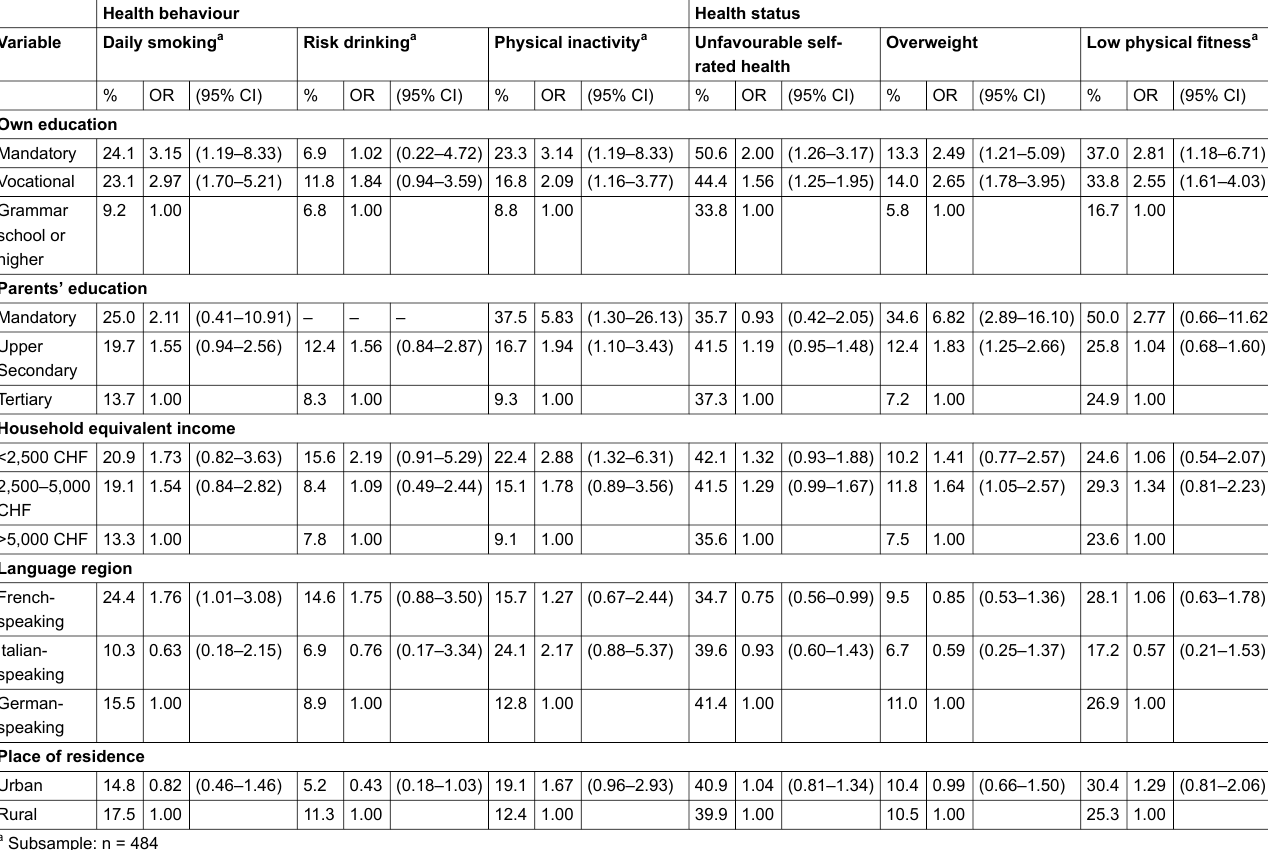
Table 3: Logistic parameter estimates for women (n = 1,467) with unfavourable health behaviour (daily smoking, alcohol risk consumption, physical inactivity) or unfavourable health status (overweight, low physical fitness, unfavourable self-rated health) as the dependent variable. Estimates presented as age-adjusted odds ratios (ORs) and 95% confidence intervals